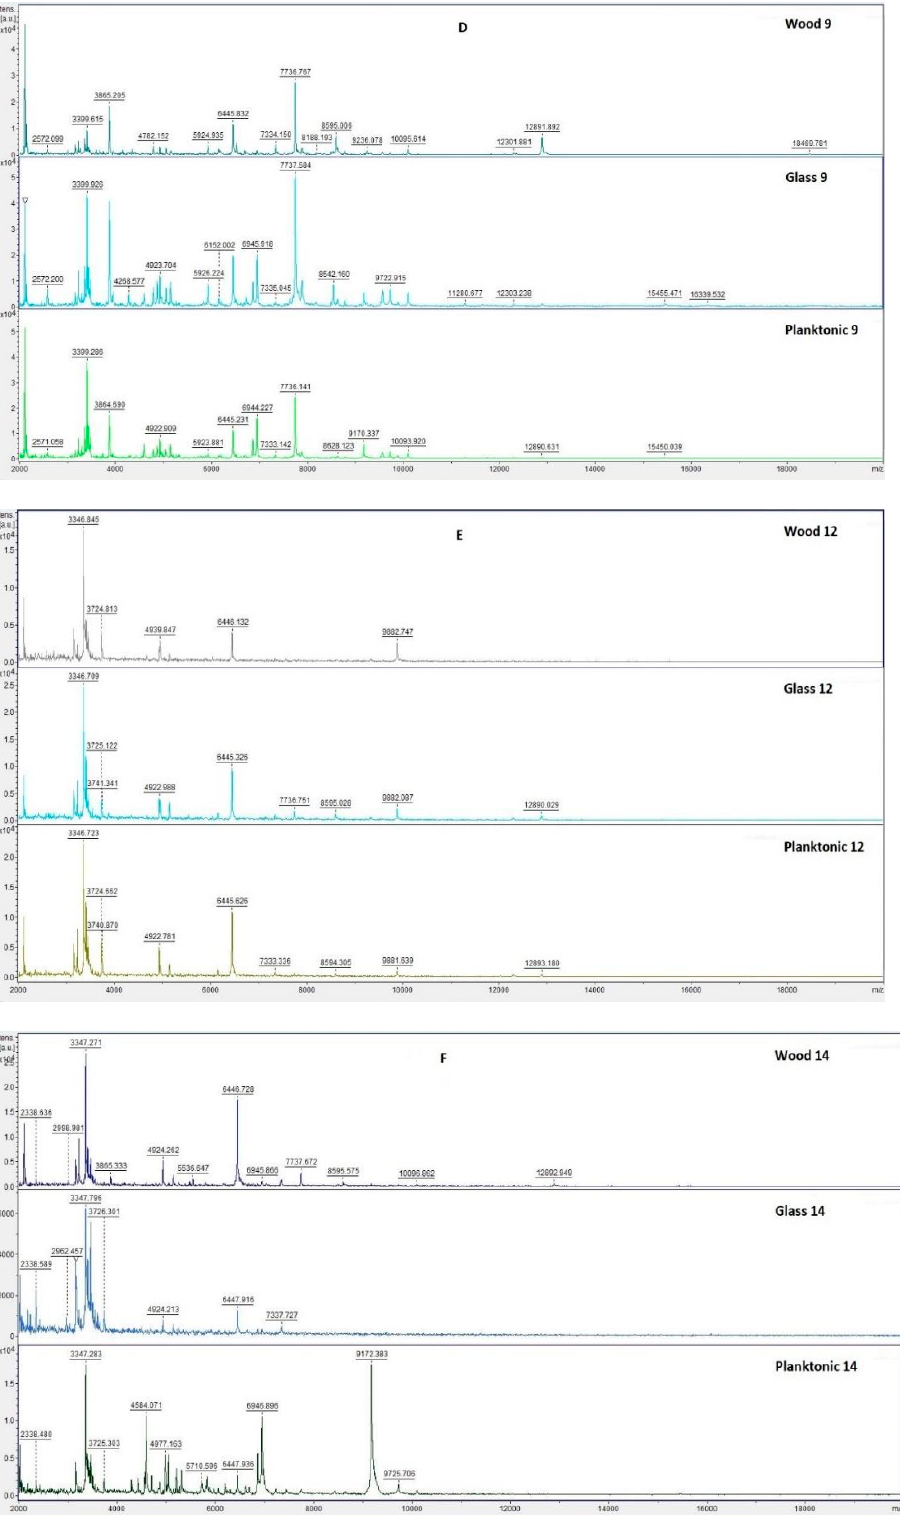
Figure 1. MALDI-TOF mass spectra of B. subtilis biofilm during development after the addition of CEO: ( A ) 3rd day, ( B ) 5th day, ( C ) 7th day, ( D ) 9th day, ( E ) 12th day, and ( F ) 14th day. Using the data obtained with mass spectrometry, a dendrogram was created to visu- alize similarities in biofilm structure that are based on MSP distance (Figure 2). It can be stated from the dendrogram that the planktonic stage (P) together with the control groups